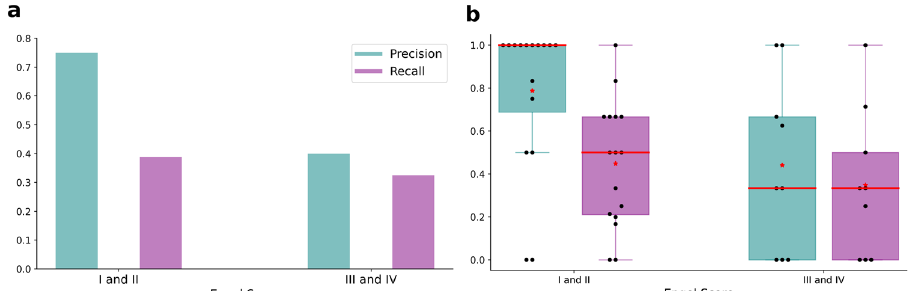
Fig. 4 Precision and recall of model-predicted EZ compared to clinical EZ hypothesis. a Precision/recall across all patients in the two patient groups: Engel score I and II: patients with post-surgical seizure freedom or with rare disabling seizures ( n = 16); Engel score III and IV: patients with minimal or no worthwhile improvement ( n = 9). b Distribution of precision/recall, computed per patient, in each group. In these box plots, red lines represent the median, red stars represent mean, and the data are overlaid as black circles. In both ( a and b ), onset tolerance ( t ϵ ) of 10 s is used for identifying EZ from the inferred source activity. The whiskers are located at 1.5 times the interquartile range from above and below. EZ, epileptogenic